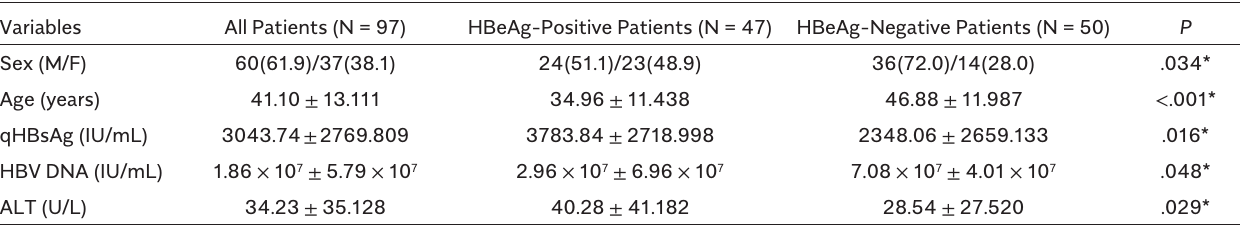
Table 1. Demographic and Laboratory Characteristics of the Patients Variables